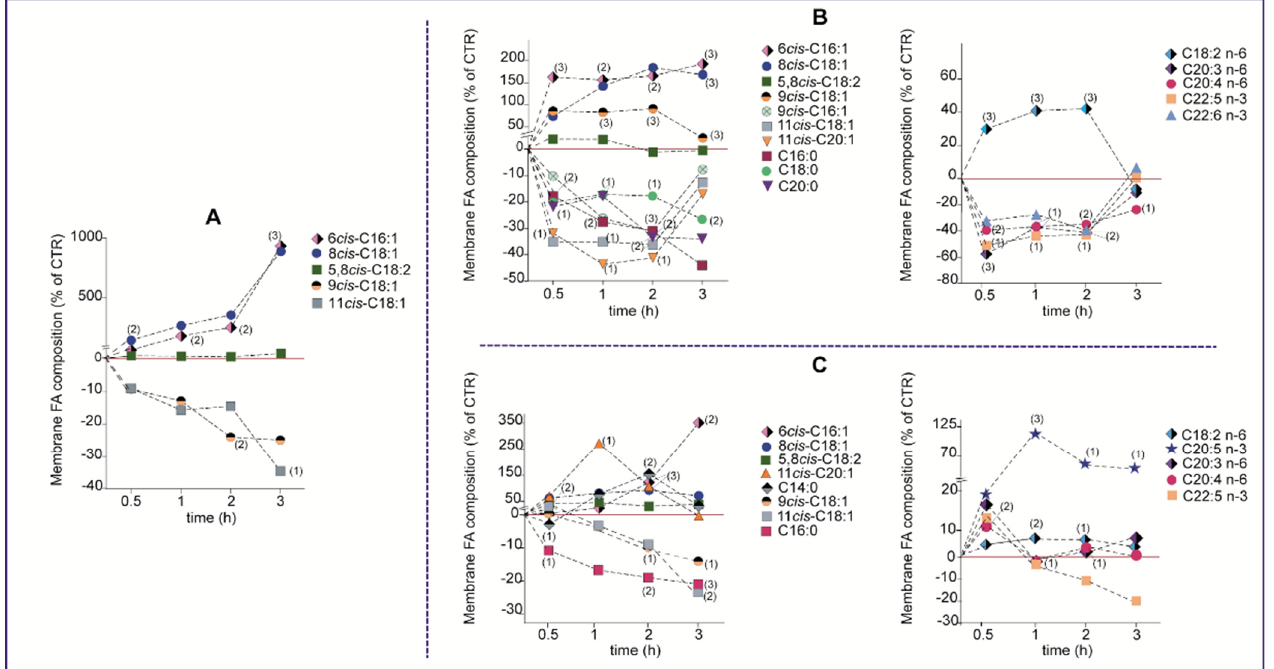
Figure 1. Time monitoring of the main statistically significant FA changes of the membrane lipidome in ( A ) MCF-7; ( B ) MDA-MB-231 and ( C ) BT-20 cells (reported as % of controls) treated with 50 μ M sapienic acid. The red line in each graph represents the values of controls (CTR). The corresponding values of each fatty acid are reported in Supplementary Information—Tables S1–S3. Numbers in parentheses indicate the statistical significance values: (1) p ≤ 0.04; (2) p ≤ 0.007; (3) p ≤ 0.0009 for ( A ); (1) p ≤ 0.0, (2) p ≤ 0.006, (3) p ≤ 0.0009 for ( B ) and (1) p ≤ 0.04; (2) p ≤ 0.009; (3) p ≤ 0.0006 for ( C ).